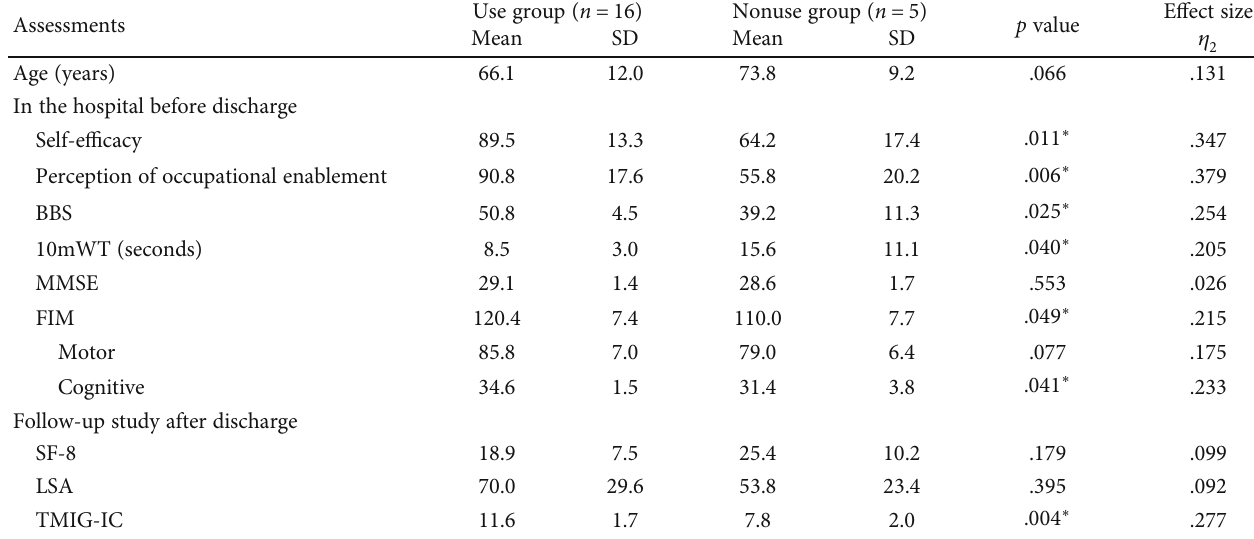
Table 2: Comparisons of assessments between the use and nonuse